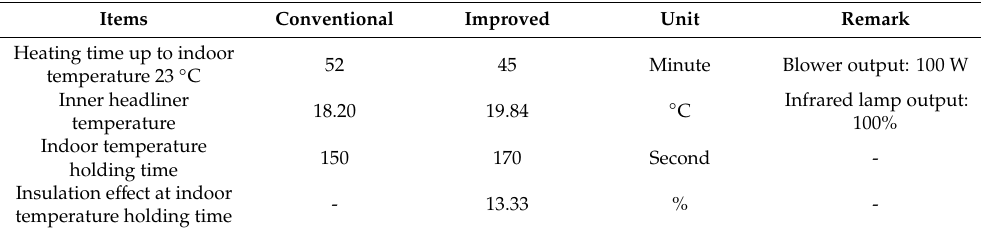
Table 2. Headliner insulation performance evaluation result.